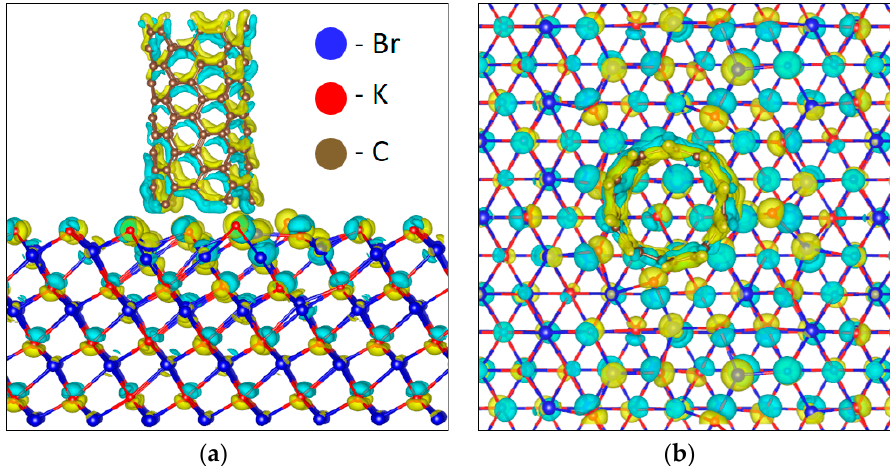
Figure 8. Electron density distribution on the KBr/CNT interface. ( a ) side view of KBr/CNT interface, ( b ) view from above of KBr/CNT interface